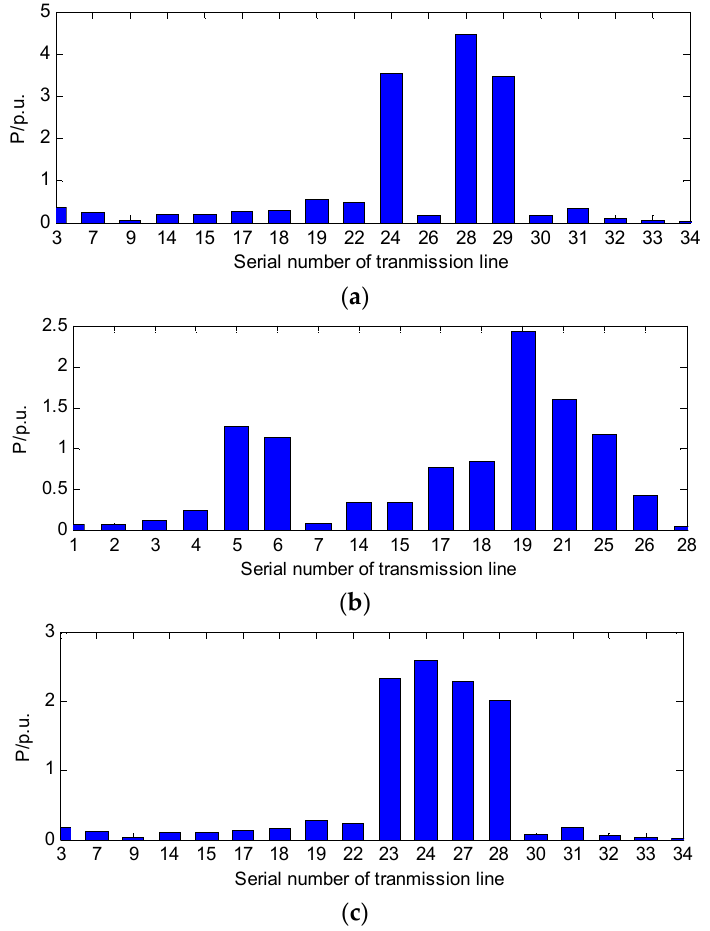
Figure 6. ( a ) Increased power of transmission lines at 1.0 s when line e 27 is removed at 0.5 s, D e27 = 0.743978 H e27 = 1 C e27 = 0.797568 W e27 = 2.541546; ( b ) Increased power of transmission lines at 1.0 s when line e 20 is removed at 0.5 s, D e20 = 0.624963 H e20 = 0.38749 C e20 = 0.930231 W e20 = 1.942685; ( c ) Increased power of transmission lines at 1.0 s when line e 29 is removed at 0.5 s, D e29 = 0.052351 H e29 = 0.540608 C e29 = 0.356604 W e29 = 0.949563.